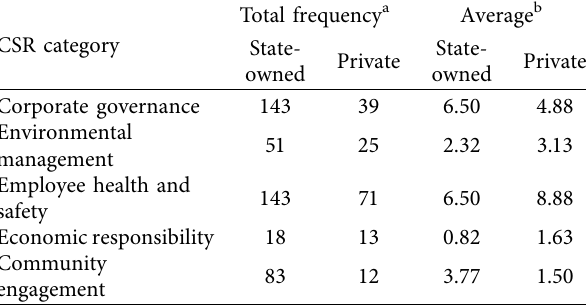
Table 5: Average number of CSR practices in each CSR